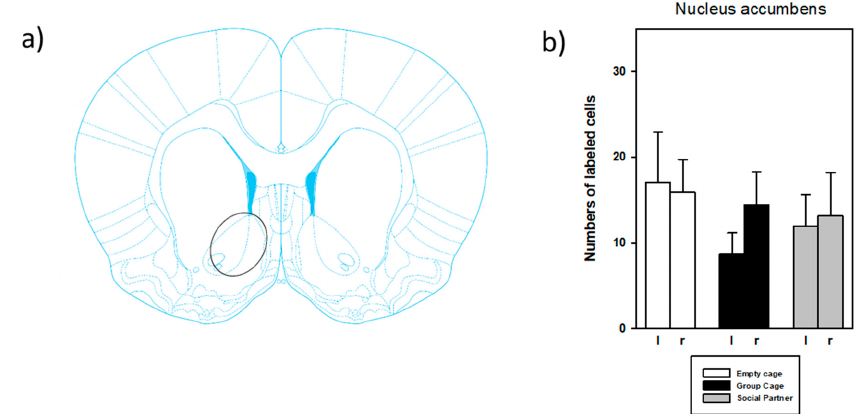
Figure 11. ( a ) Schematic section according to plate 16 (Bregma 2.04 mm) of the atlas of Paxinos and Watson [42] showing the region of interest for counting c-fos-positive cells in the NAcc. ( b ) Numbers of c-fos-positive cells in the NAcc of the left (l) and right hemisphere (r) in animals, which had access to a conspecific (Social Partner, grey bars), no social contact (Empty Cage, white bars) or their cage mates (Group Cage, black bars) immediately after playback in the initial test. Data are presented as means + SEM.